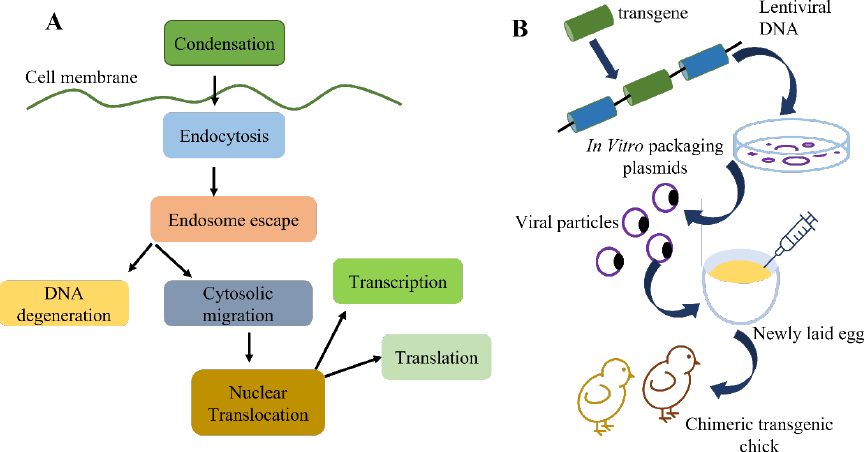
Figure 4. ( A ) Non-viral vector method of transgenesis; ( B ) viral vector transfer of genes (modified Figure 4. ( A ) Non - viral vector method of transgenesis ; ( B ) viral vector transfer of genes ( m odified from Mozdziak and Petitte [29]). from Mozdziak and Petitte